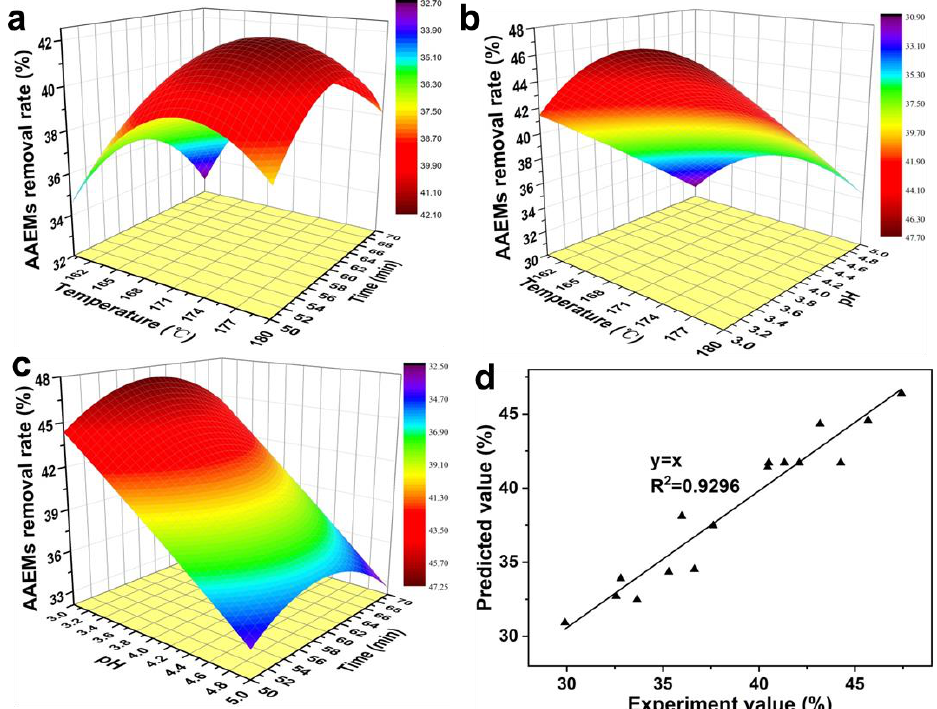
Figure 2. Interaction of reaction temperature, time and pH on the total removal rate of AAEMs. (( a ), interaction between temperature and time on the total removal rate of AAEMs. ( b ), interaction between temperature and pH on the total removal rate of AAEMs. ( c ), interaction between pH and time on the total removal rate of AAEMs. ( d ), fitting relationship between the predicted value and the experiment value).